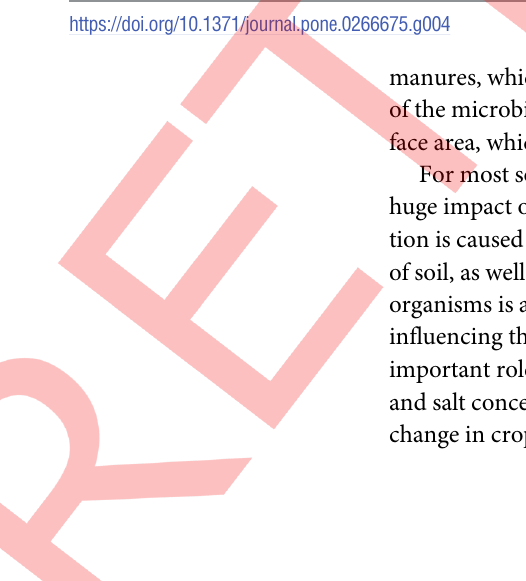
Fig 4. The effect of different organic manure treatments on soil chemical properties, where ( a ) Fruit yield; ( b ) Fruits per plant; ( c ) Fruit weight; d) Rind thickness. Various asterisk on bars show the significant differences ( P < 0.05) with vertical bars as standard errors ( n = 4) ( ���� > ��� > �� > � >